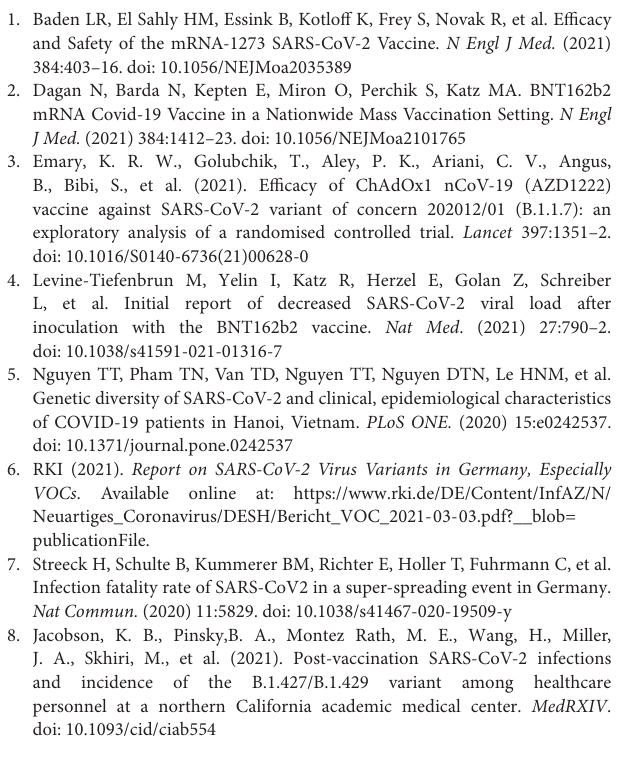
Supplementary Figure 1 | Spike (S) and nucleocapsid (N)-specific ELISAs for SARS-CoV-2 antibodies were performed at 3 different time points after infection. The result of the Euroimmun ELISAs is given as a ratio of extinction of sample/extinction of calibrator and is considered positive between 1.1 and